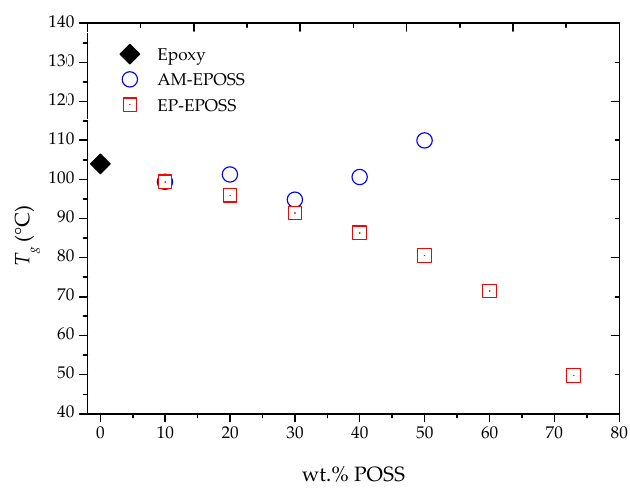
Figure 4. The effect of POSS type and content on the glass transition temperature of EP–EPOSS and AM–EPOSS samples. The error bars are smaller than |±1.6| °C.